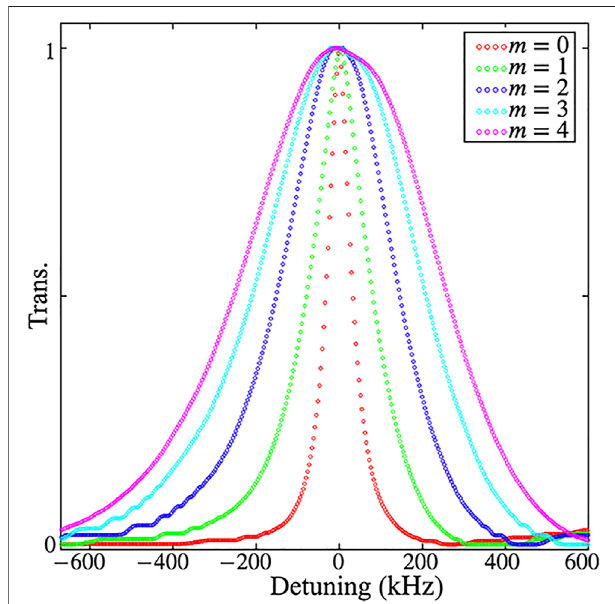
FIGURE4| TheHanleresonancesignalsofsymmetricVBsasafunction of the total Zeeman shift δ (cid:1) 2g μ B | B | . m (cid:1) 0 is the linearly polarized Gaussian beam.